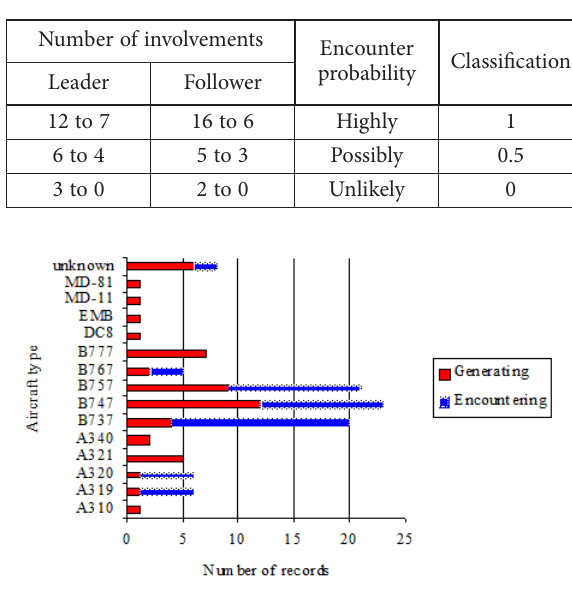
Figure 1. Number of airplane engagements in vortex-encounter